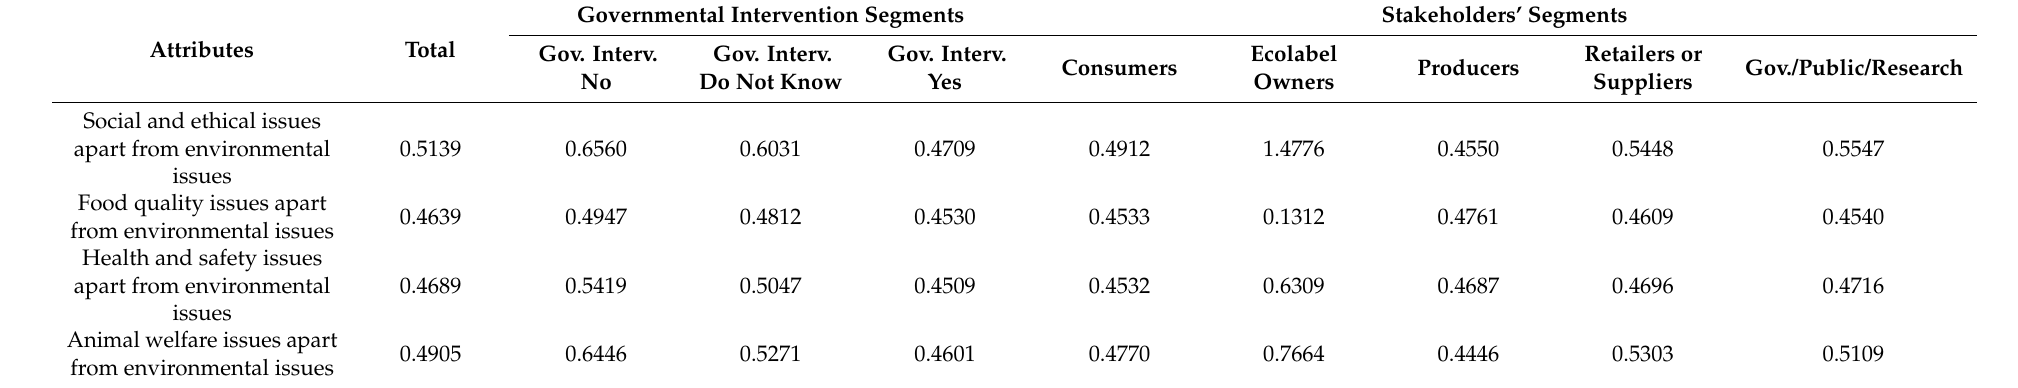
Table 7. Elasticity values of the level of acceptance for the inclusion of additional issues apart from environmental ones on a hypothetical EU ecolabel for fishery and aquaculture products (FAPs). Total, governmental intervention and stakeholders segments of